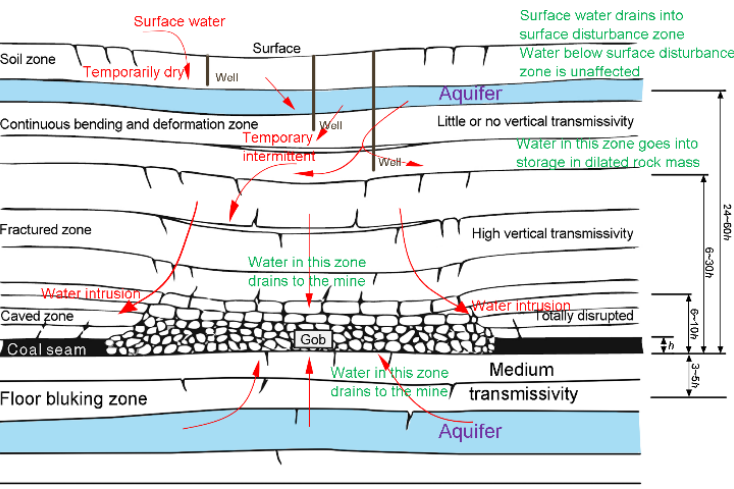
Figure 5. Overburden movement resulting from long ‐ wall mining (modified from Kendorski’s work